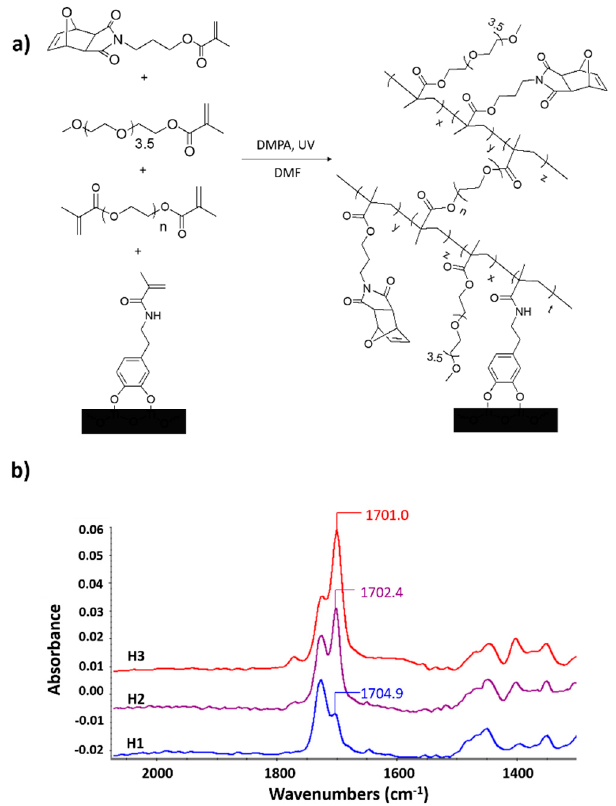
Figure 1. ( a ) Synthesis of FuMaMA containing latent reactive hydrogels on titanium. ( b ) ATR-FTIR spectra of the hydrogels.